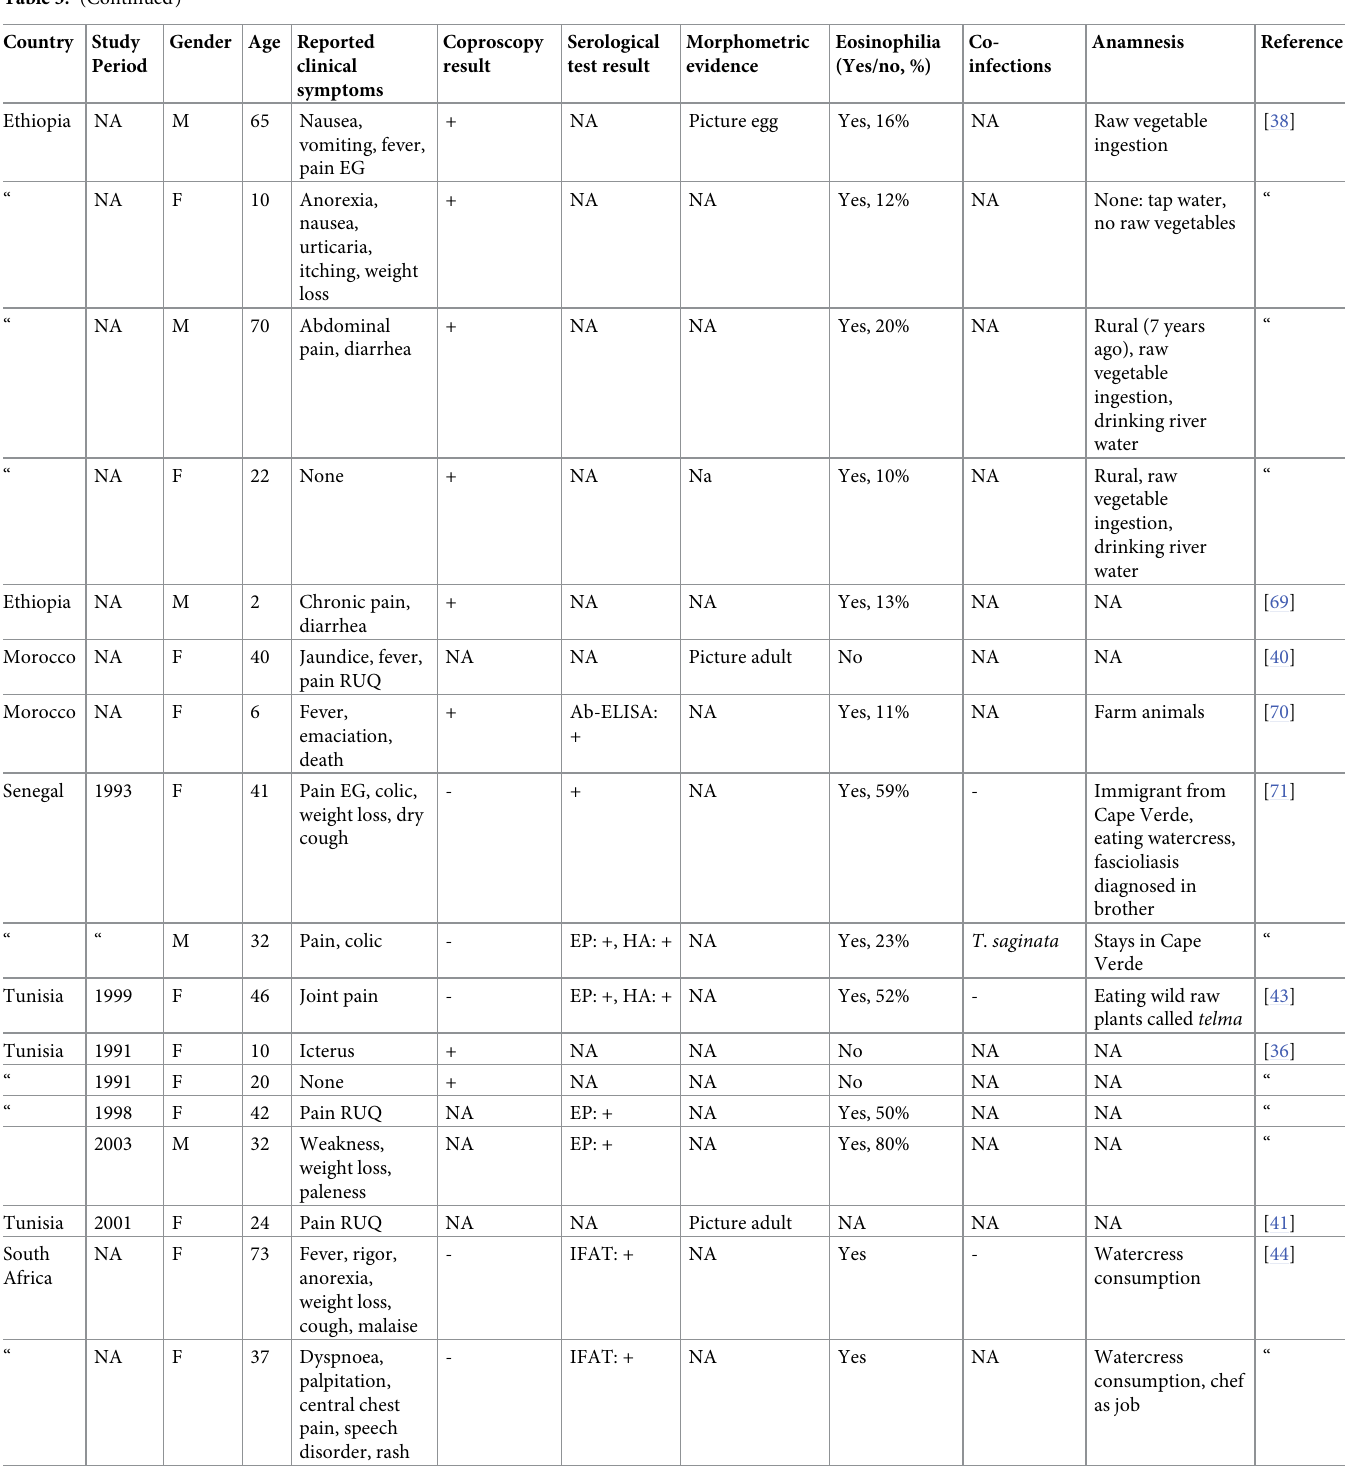
Ab-ELISA: antibody-enzyme-linked immunosorbent assay, EG: epigastric, EP: electrophoresis, HA: hemagglutination, IFAT: indirect fluorescent antibody test, RUQ: right upper